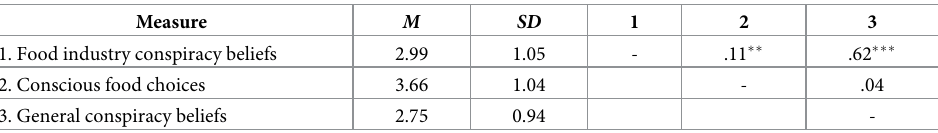
Table 1. Means, standard deviations, and zero-order correlations (Study